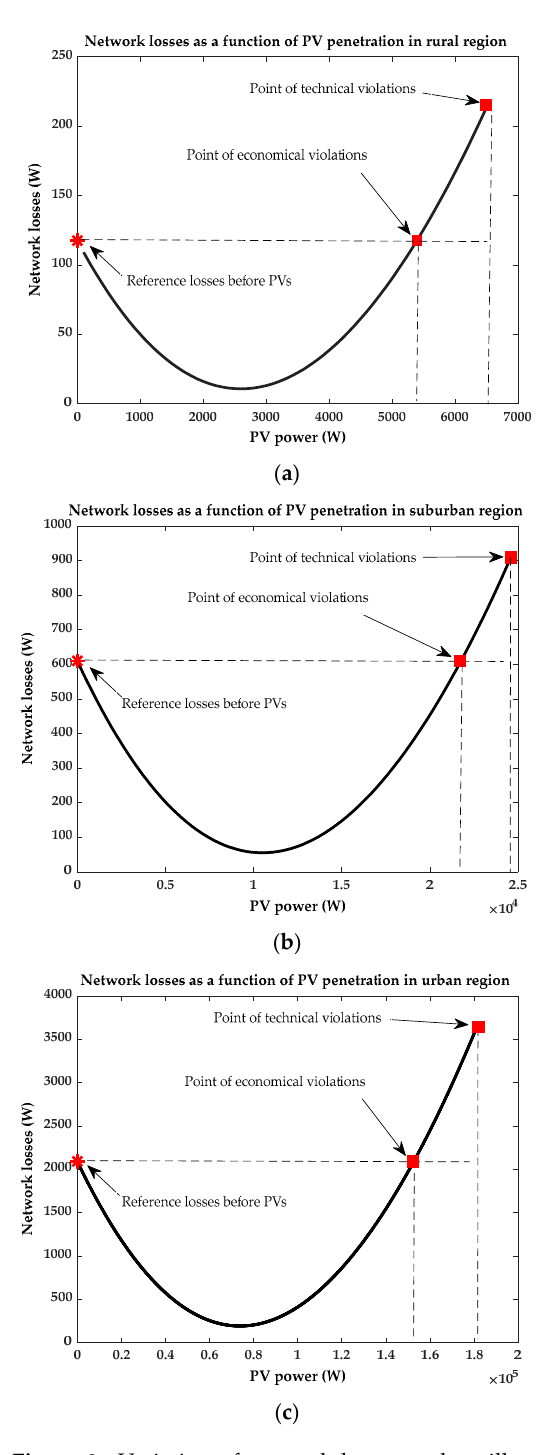
Figure 8. Variation of network losses and an illustration of a margin between economical and technical violations: ( a ) Rural; ( b ) suburban; ( c ) urban.